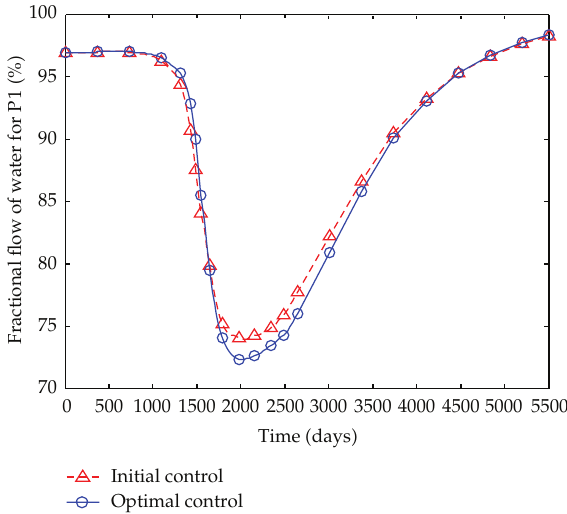
Figure 8: Fractional flow of water for the production well P1.